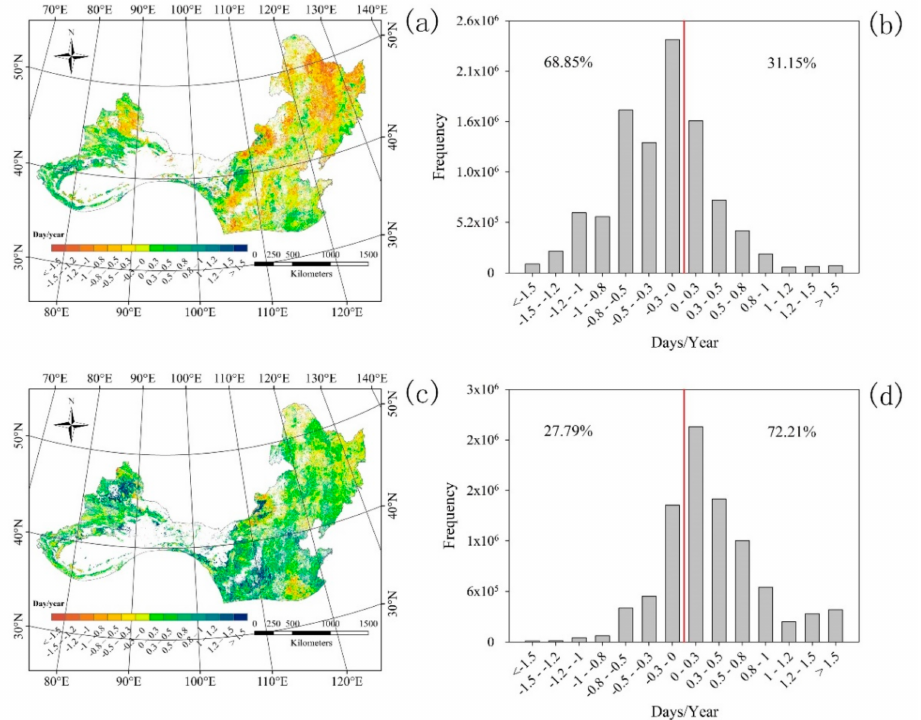
Figure 1. Trends of the start of season (SOS) ( a ) and end of season (EOS) ( c ) under the impacts of climate change and the impacts of non-climate change. ( b , d ) show the corresponding frequency distributions of SOS and EOS,